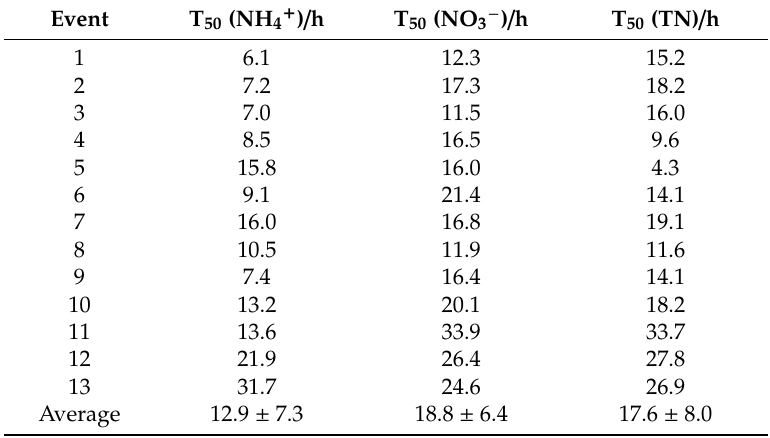
Table A2. T 50 for NH 4 + , NO 3 − and TN in SZ during dry